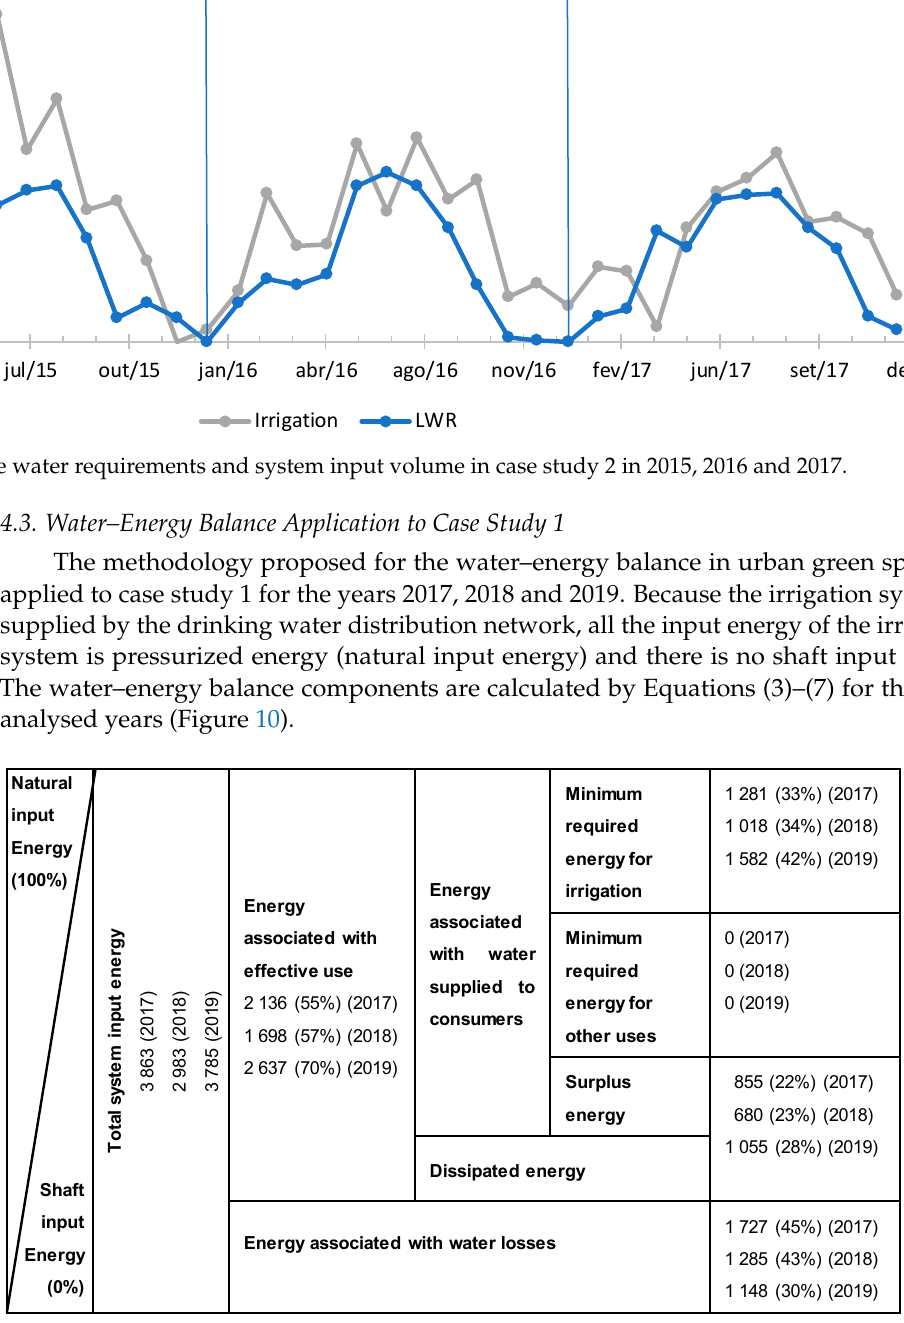
Figure 10. Water–energy Balance for Case study 1 in 2017, 2018 and 2019 (kWh/year).